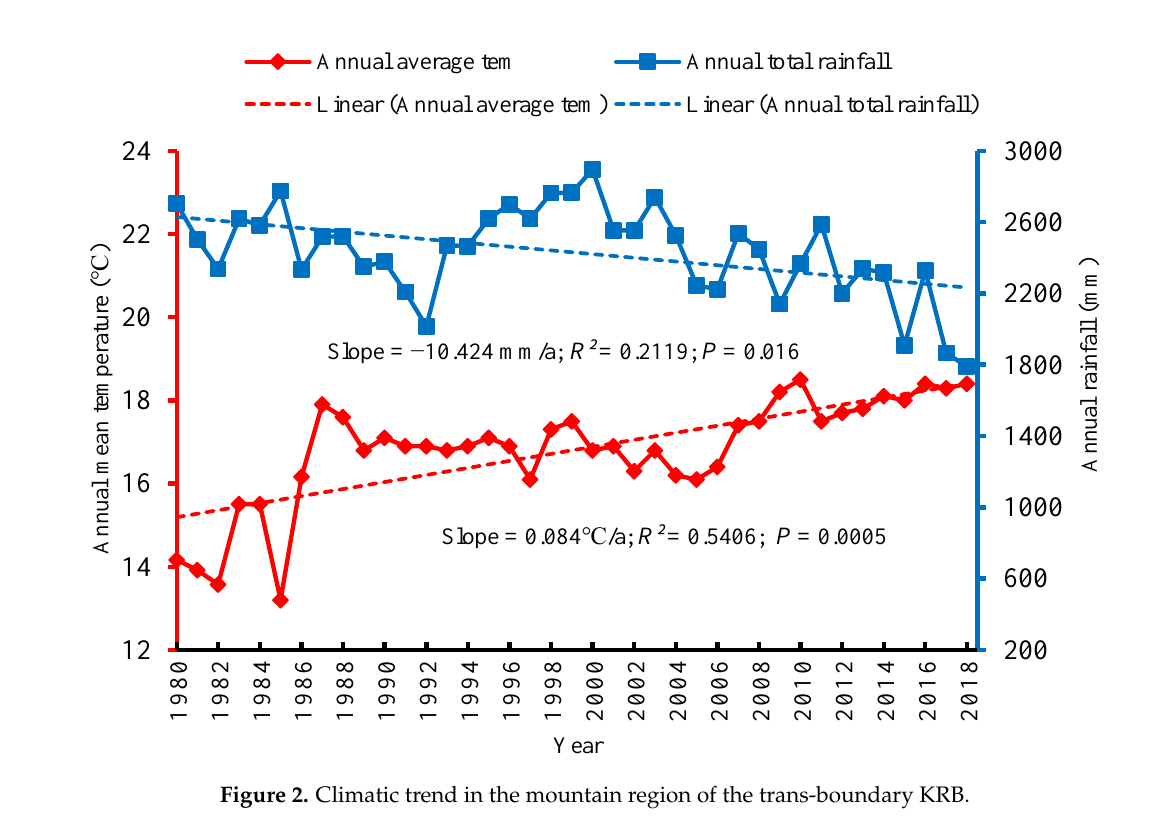
Figure 2. Climatic trend in the mountain region of the trans-boundary KRB. Climatic trends for the hill region of the basin indicated that the mean annual tem- perature had also risen significantly at a rate of 0.0975 °C/a between 1980 and 2018. The increased rate of temperature for this region was also positively correlated with a p value of 0.0002. The trend for the annual rate of temperature increase was highest for the hill region than other regions of the basin. Similarly, the total annual precipitation between 1980 and 2018 in the hill region showed a sharply decreasing trend of −8 .3513 mm/a. The total annual precipitation for this region also positively correlated with a p value of 0.0023 (Figure 3). The station-based climatic trends for the hill region of the basin did indicate noticeable climate change scenarios over the period 1980 and 2018 together with the im- Slope = −8.3513 mm/a; R² = 0.2429; P = 0.0023 pact on the farmers’ livelihoods.